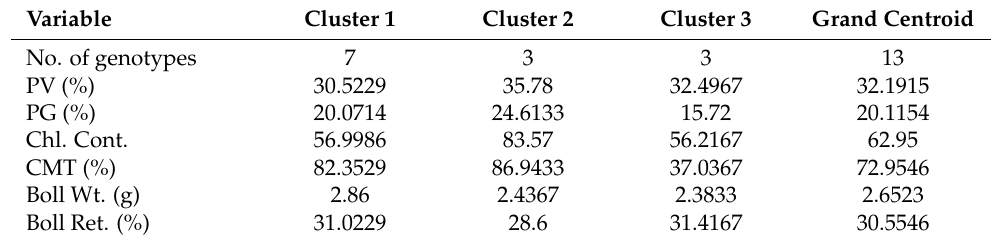
Figure 6. Cluster analysis of thirteen accessions of upland cotton evaluated for high-temperature regimes. Table 7. Means of clusters of 13 cotton genotypes of all observed tr under high-temperature